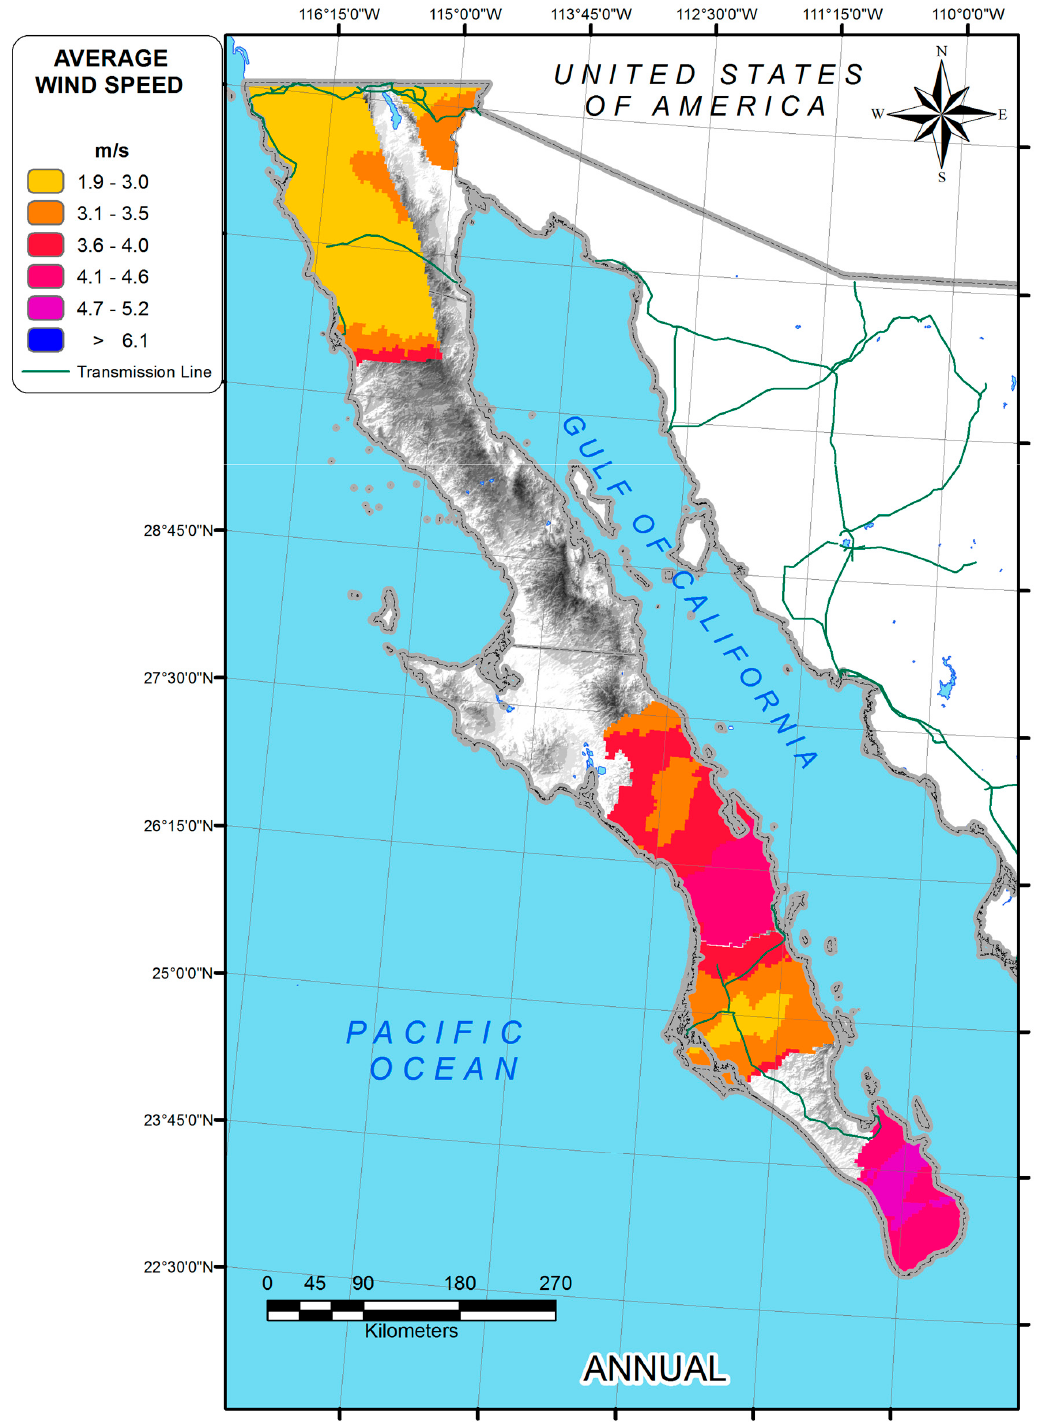
Figure 11. Annual wind speed at the Baja California Peninsula.